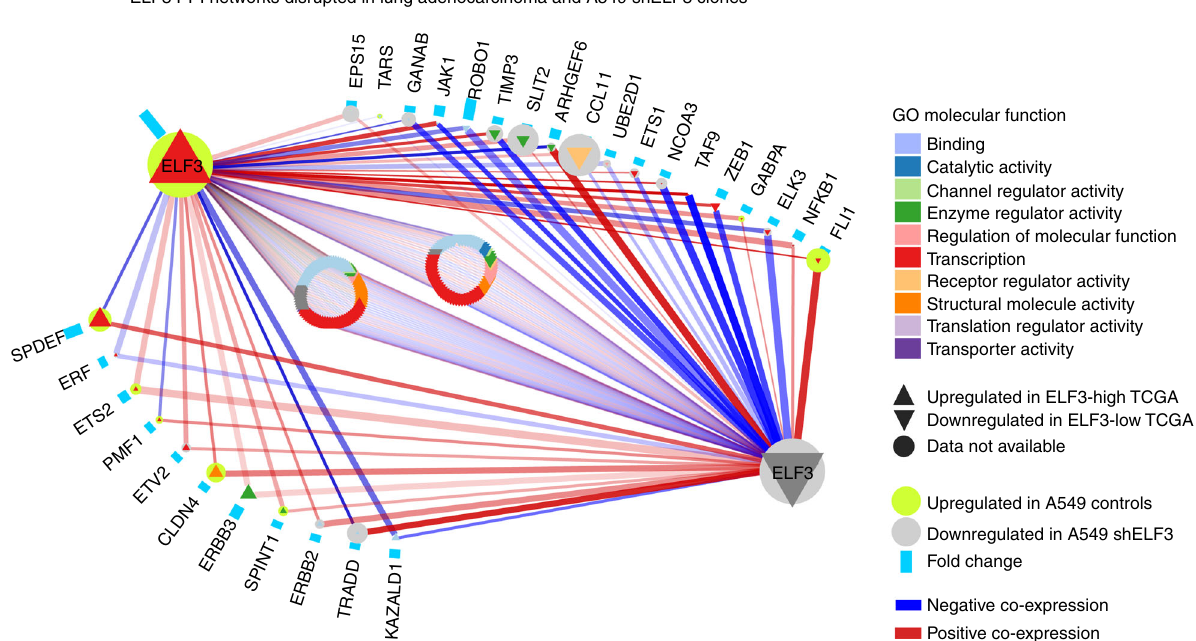
Fig. 5 Pan-cancer analysis of ELF3 protein – protein interaction networks reveals tissue speci fi city. a Tissues are ordered vertically according to decreasing number of altered ELF3 PPIs. Disrupted PPIs were identi fi ed by comparing cancer pro fi les with non-malignant pro fi les in the same tissue types, with PPIs gained in cancer shown in red, and those lost in cancer shown in blue. The largest disrupted network was in lung cancer, with 111 PPIs gained and 85 PPIs lost in cancer. Considering all altered PPIs, 57% were speci fi c to one tissue and only 15 PPIs were gained or lost in more than three tissues. b The largest disrupted network was in lung adenocarcinoma (LUAD), with 14 lost and 9 gained PPIs in cancer. The only altered PPI common to LUAD and squamous cell carcinoma (LUSC) was CCL11, whereas MYC, GLI2, and NKX2 – 1 were common to LUAD and large cell carcinoma (LULC). The protein names of the altered PPIs are indicated at the bottom of the fi gure. c Comparison of altered ELF3 PPIs between TCGA LUAD data and isogenic A549 cells (KRAS mutant samples only). Twenty-nine out of 156 PPI partners were signi fi cantly deregulated in LUAD with high ELF3 expression and are color-coded by their respective GO Molecular Function. Proteins at the left-side show signi fi cantly upregulated (up-triangles) mRNAs when ELF3 is highly expressed in TCGA, and right-side proteins represent signi fi cantly downregulated (down-triangles) mRNAs when ELF3 is highly expressed in TCGA. Edge color represents positive co-expression (red edges) or negative co-expression (blue edges), and edge thickness is proportional to the number of data sets supporting the edge. Node outline color represents up- or down-regulation in A549 control cells compared with clonal shELF3 cells ( n = 3 biological replicates). Therefore, bright green outline around up-triangles, and gray outline around down-triangles indicate consistency between TCGA and isogenic cell line data. Node size is proportional to the total number of altered PPIs, and node highlight size is proportional to the FDR corrected p value of expression fold change in isogenic cell lines, whereas blue bars indicate the fold change value. Circles in the center indicate ELF3 partners whose differential expression was not statistically signi fi cant. PPI = protein – protein